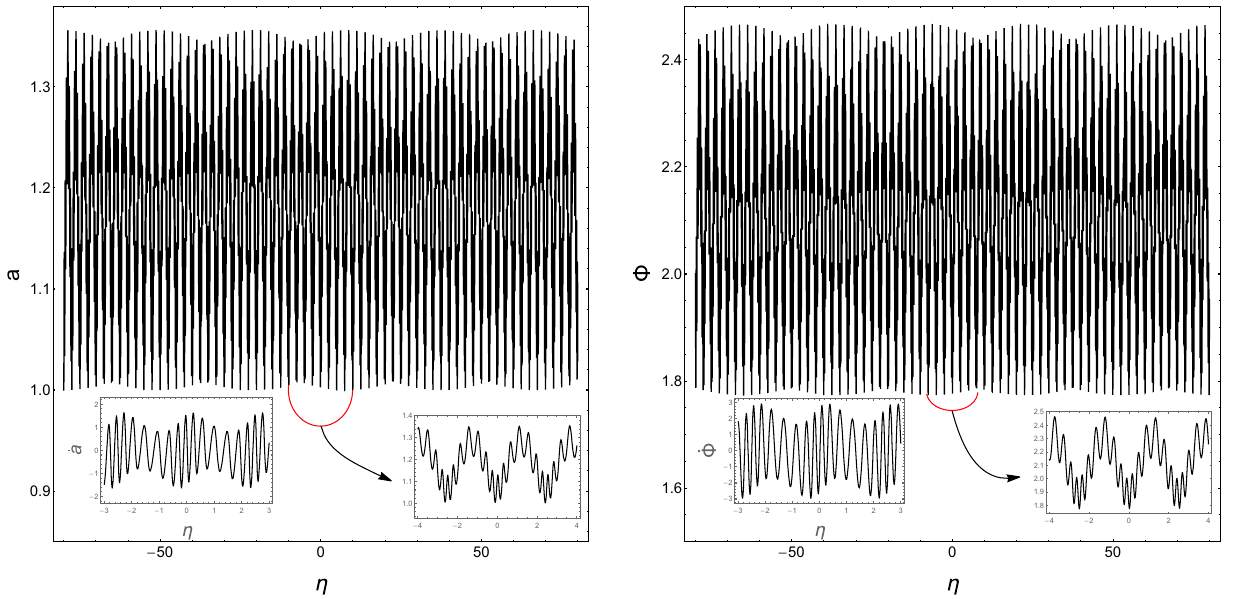
Fig. 7 Dynamical evolution of scale factor (left panel) and the BD scalar field (right panel) for γ = 2, ω = − 2 . 8 and r = − 3. The initial values for dynamical variables has been set as X 0 = Y 0 = 0,